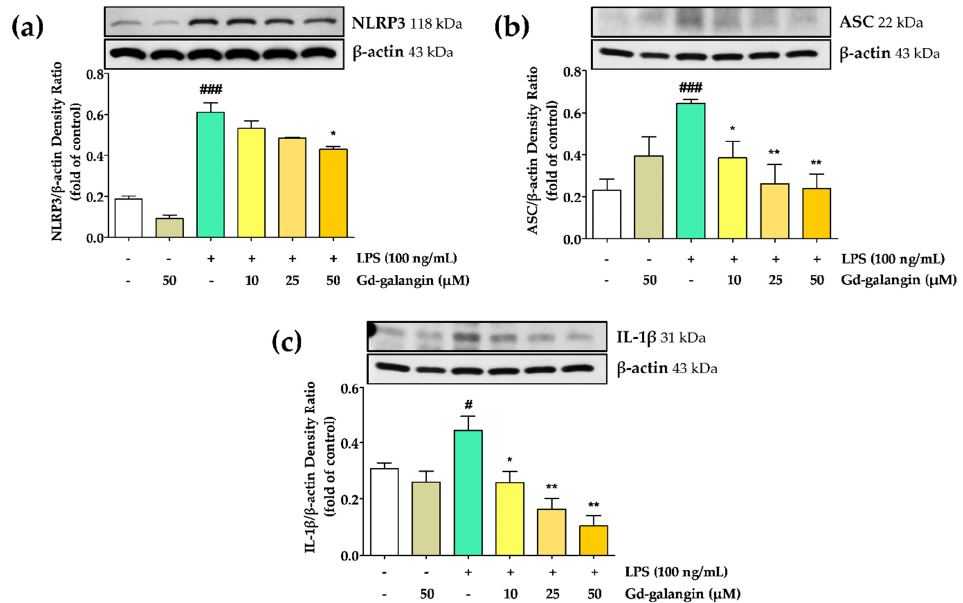
Figure 8. Anti-inflammatory effect of Gd-galangin in lipopolysaccharide (LPS)-induced RAW 264.7 cells. (a, b) Nucleotide binding and oligomerization domain-like receptor family pyrin domain-containing protein 3 (NLRP3)-related factors and ( c ) their product IL-1 β were determined with Western blot analysis. (Data are shown as the mean ± SEM, t -test, n ≥ 3. # p < 0.05, ### p < 0.001 compared to control group; * p < 0.05, ** p < 0.01 compared to LPS-stimulated group).